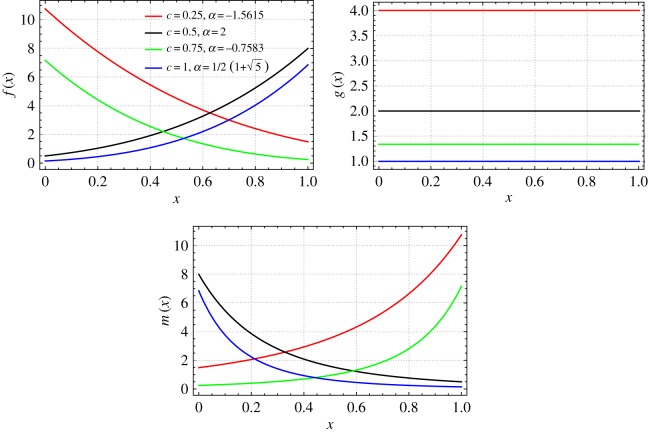
Mass, bending stiffness and mass moment of inertia functions of a non-uniform beam isospectral to a uniform beam (Case 3: c={0.25,0.5,0.75,1}, α={−1.56155,2,−0.758306,12(5+1)}, k=−1 and r0/L=0.09).